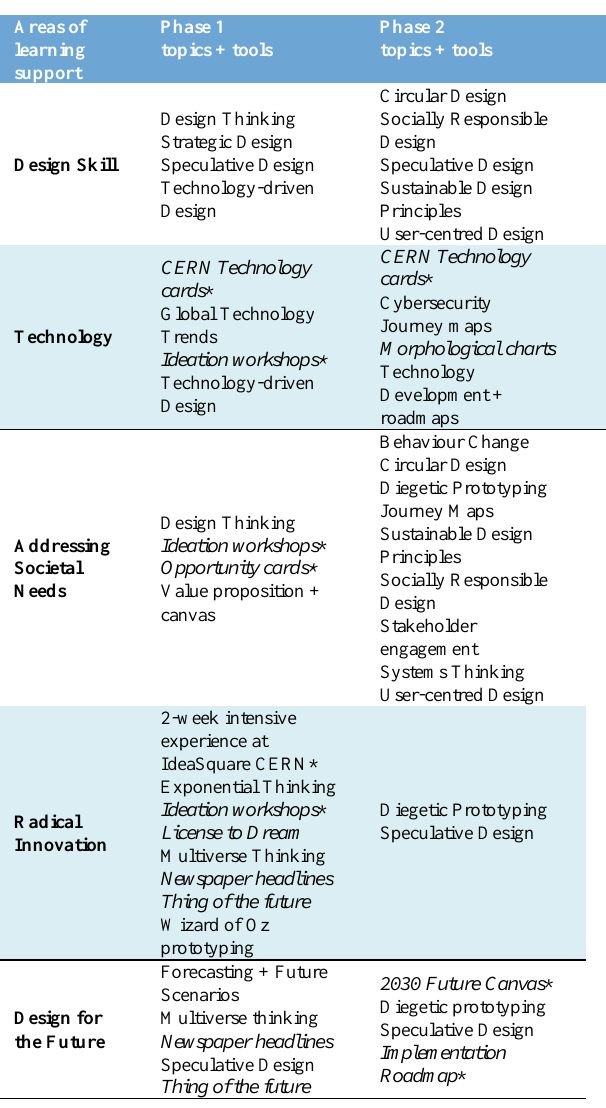
Table 1. Curriculum map for phases 1 and 2 of CBI A 3 supporting design skills and the four domains. Regular text denotes topic areas that cover theory, practices/tools and activities. Italics denotes a tool or activity only. *Denotes original to CBI A 3 .